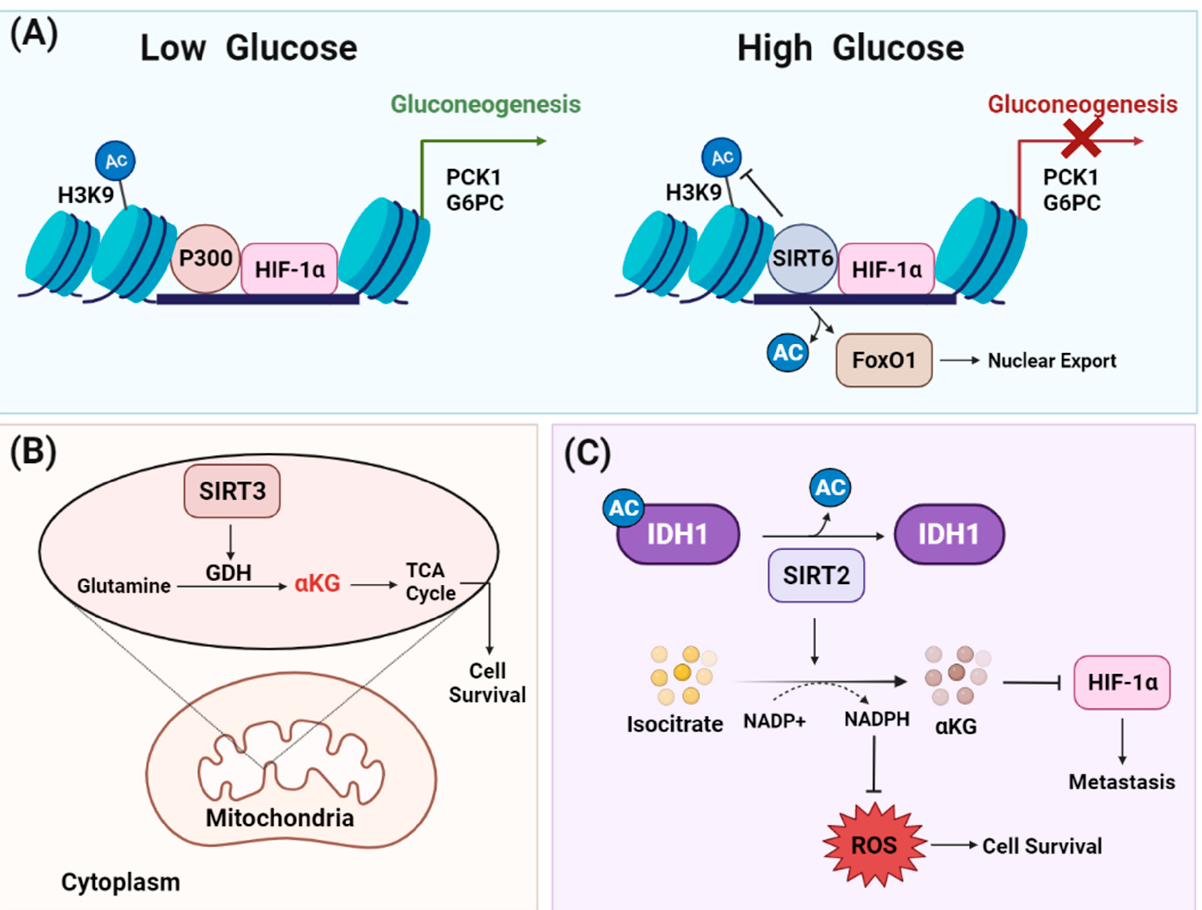
Figure 5. HDACs elicit metabolic reprogramming to support cell survival under metabolic stress. Different HDACs are involved in reglueing several metabolic pathways. ( A ) Under low glucose levels, histone acetyltransferase p300 acts as coactivator for HIF-1 α to induce transcription of genes involved in gluconeogenesis. Under high glucose levels, SIRT6 inhibits gluconeogenesis by acting as a co-repressor of HIF-1 α transcriptional activity by deacetylating H3K9 at the promoter sites of its target glycolytic genes such as PCK1 and G6PC, which are a rate-limiting enzymes in glucose synthesis. SIRT6 deacetylates the transcription factor FoxO1, which results in its export to the cytoplasm. Excluding FoxO1 from the nucleus reduces the expression of PCK1 and G6PCm thereby inhibiting gluconeogenesis. ( B ) The mitochondrial lysine deacetylase SIRT3 promotes glutamine flux to the TCA cycle via glutamate dehydrogenase, which, in turn, shields the cancer cells from metabolic stress and maintains cell survival. ( C ) SIRT2 deacetylates IDH1 at lysine 224 and stimulates its metabolic activity. IDH catalyzes the decarboxylation of isocitrate to produce alpha-ketoglutarate ( α KG), which is important for the hydroxylation and degradation of HIF-1 α . Consequently, SIRT2- dependent IDH1 deacetylation inhibits metastasis as well as decreasing reactive oxygen species (ROS) levels by producing NADPH, an ultimate donor for ROS-detoxifying enzymes. Abbreviations: HIF-1 α , hypoxia-inducible factor-1; FoxO1, Forkhead box protein O1; PCK1, phosphoenolpyruvate carboxykinase 1; G6PC, glucose-6-phosphatase catalytic subunit; IDH1, isocitrate dehydrogenase 1; α KG, alpha-ketoglutarate; ROS, reactive oxygen species; GDH, glutamate dehydrogenase; TCA, tricarboxylic